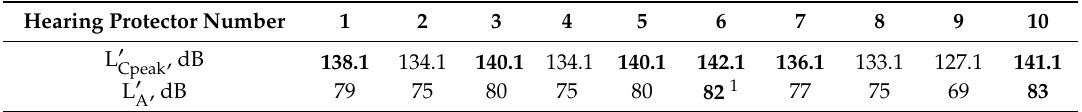
Table 2. The highest values of noise parameters under hearing protectors determined from all the measuring situations included in the study (53 shooting